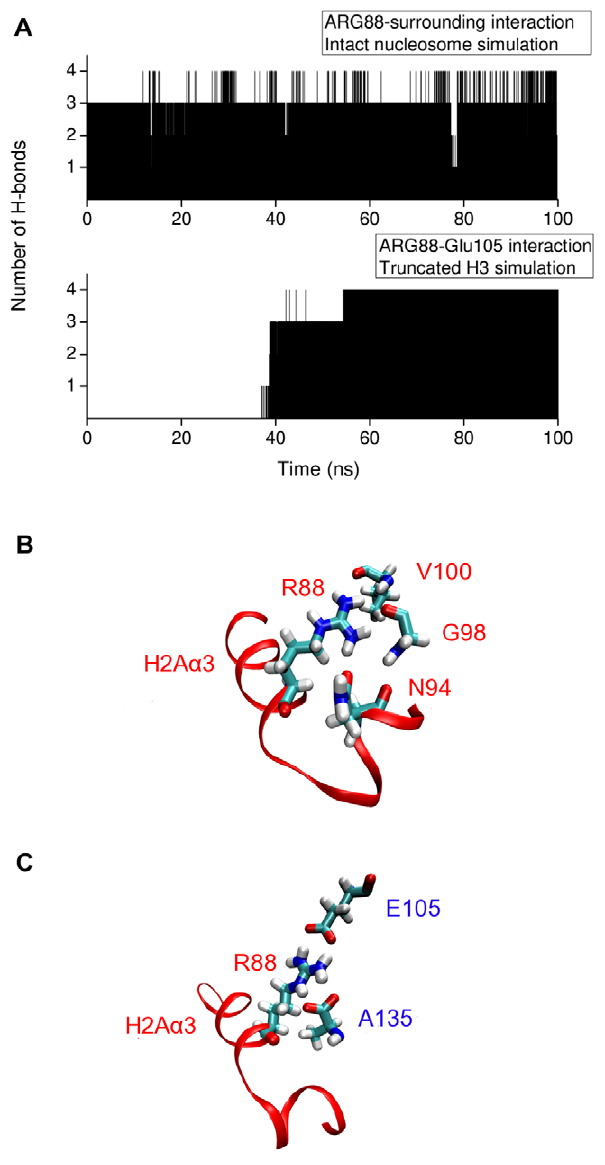
Figure 9. Interactions with Arg88 of H2A(2) during the intact and H3 tail-truncated simulations. (A) Number of H-bonds between Arg88 and selected surrounding residues from intact and H3 tail-truncated simulations. The selected surrounding residues are shown in (B) and (C). (B) Arg88 H-bonds to Asn94, Gly98 and Val100 of H2A(2) during the intact nucleosome simulation. (C) Arg88 H-bonds to Glu105 of H3(1) and Ala135 of H3(2) in the H3 tail-truncated simulation. Destabilization of the H2A C terminus upon H3 tail truncation affects the C terminus-DNA contact. In the intact nucleosome simulation the H2A C terminus (Lys118 and Lys119) makes stable contact with the DNA through hydrogen bonding. Upon H3 tail truncation the C terminus switches between states ‘in contact’ with DNA and ‘detached’ (Fig. 12C). Truncation of H2A tails removes H2A C terminus-DNA contacts. This affects the remaining part of the H2A tail differently in the independent simulations : in simulation 1 the H2A docking domain breaks contact with Lys44 and Ile51, in the other only minimal loss of contact with Lys44 is observed (Fig. 13).